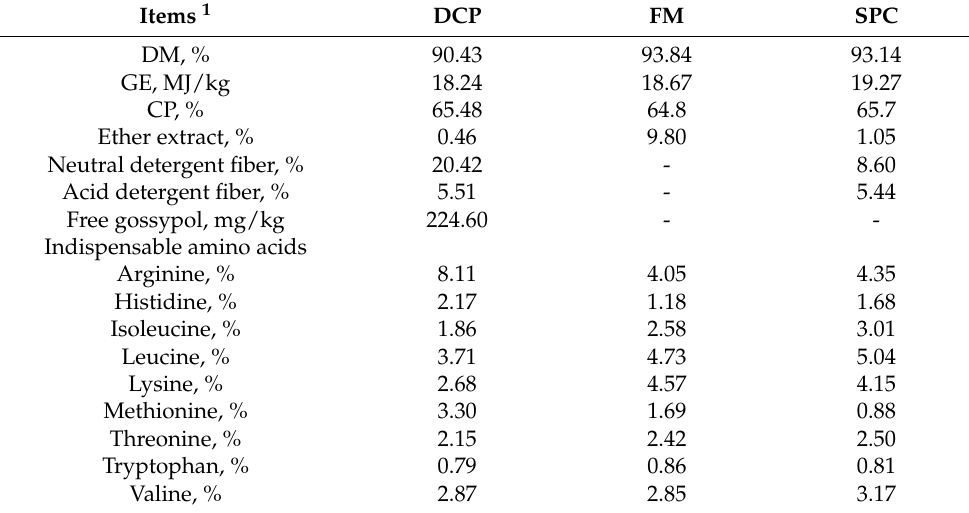
Table 1. The chemical compositions of degossypolized cottonseed protein, fish meal and soybean protein concentrate (as fed